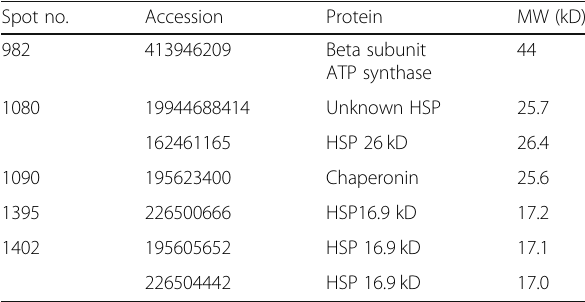
Table 1 Identification of the proteins induced as a response of K1 maize inbred to HS at 45 °C via NCBI databases Spot